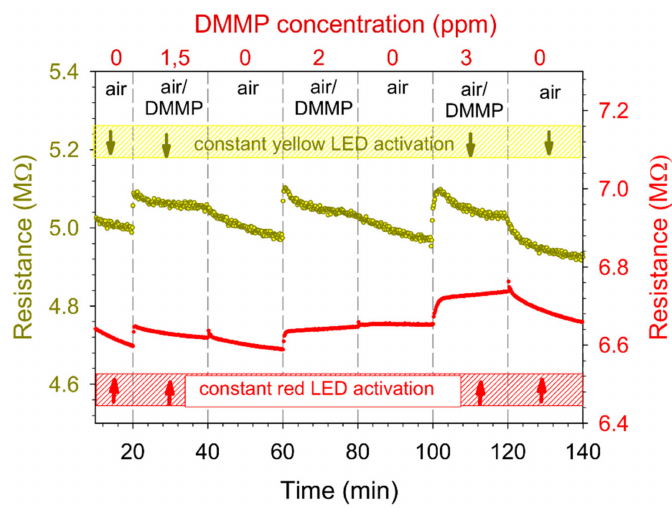
Figure 2. Time-dependent resistance plot in the room temperature of the RR-P3HT layer activated by red and yellow diodes in the presence of three di ff erent DMMP concentrations (1.5 ppm, 2 ppm and 3